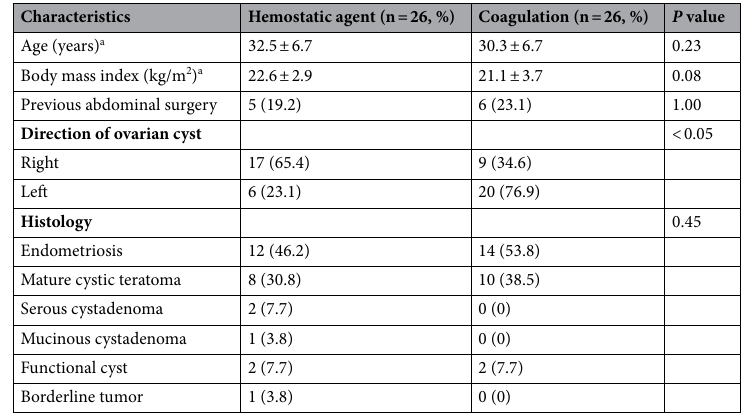
Table 1. Clinicopathologic characteristics. a Data were shown as mean ± standard deviation.